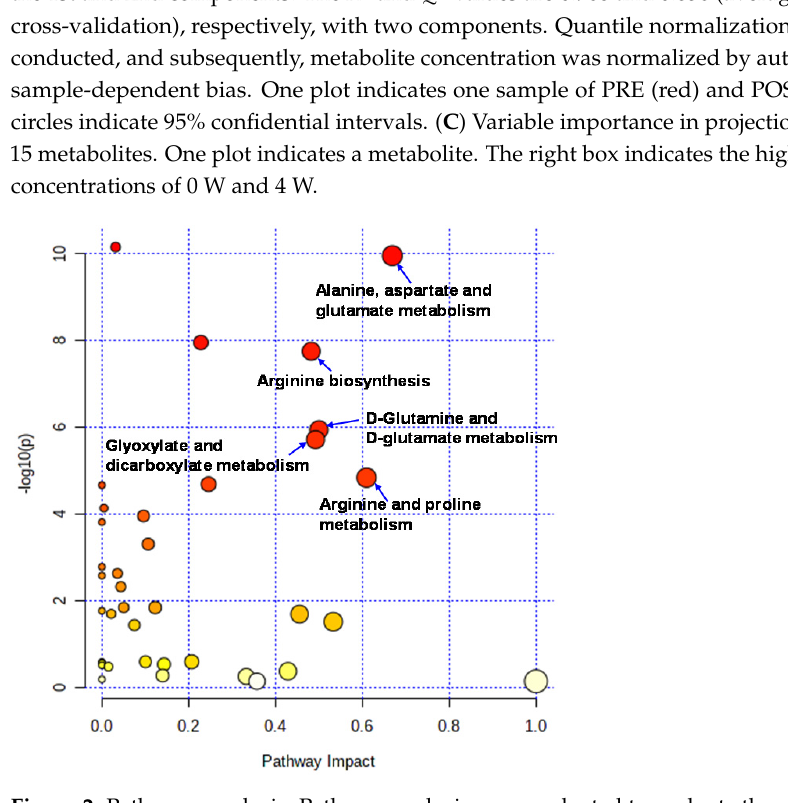
Figure 2. Pathways analysis. Pathway analysis was conducted to evaluate the pathway-level change between PRE and POST. The X -axis indicates pathway impacts. The Y -axis indicated − log 10 (P) of each pathway.